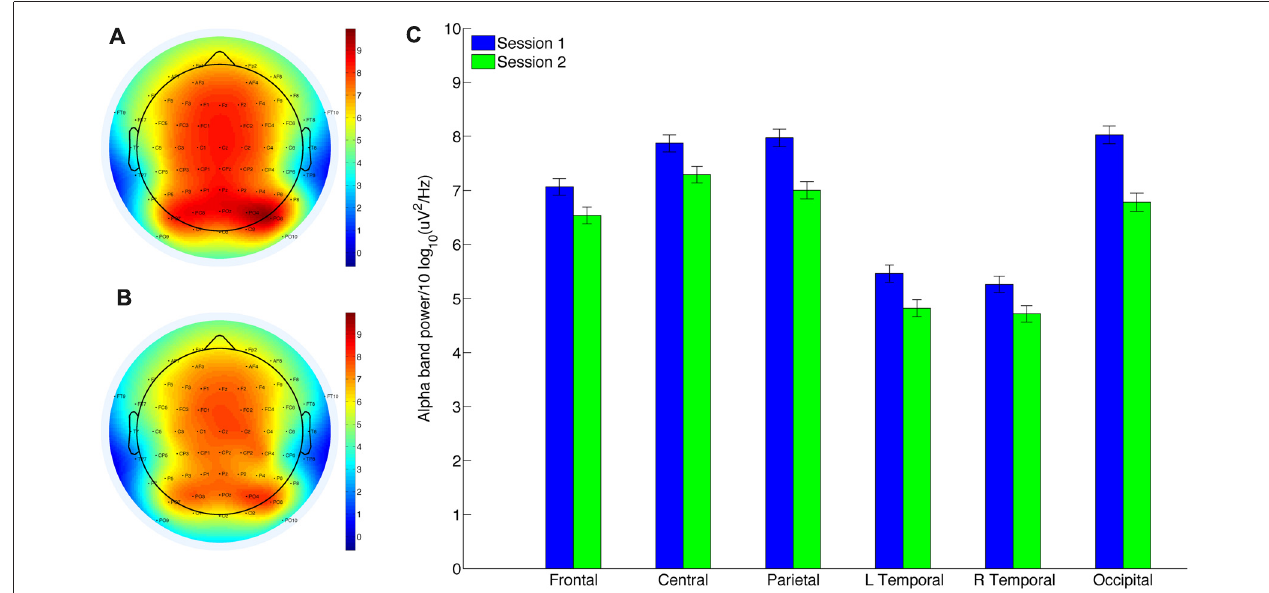
FIGURE 2 | Alpha power decreases significantly post-intervention in all six recording clusters during meditation ( Table 1 ). Topographic plot of alpha power during meditation. (A) Before intervention. (B) After intervention. (C) Mean alpha power for each region.